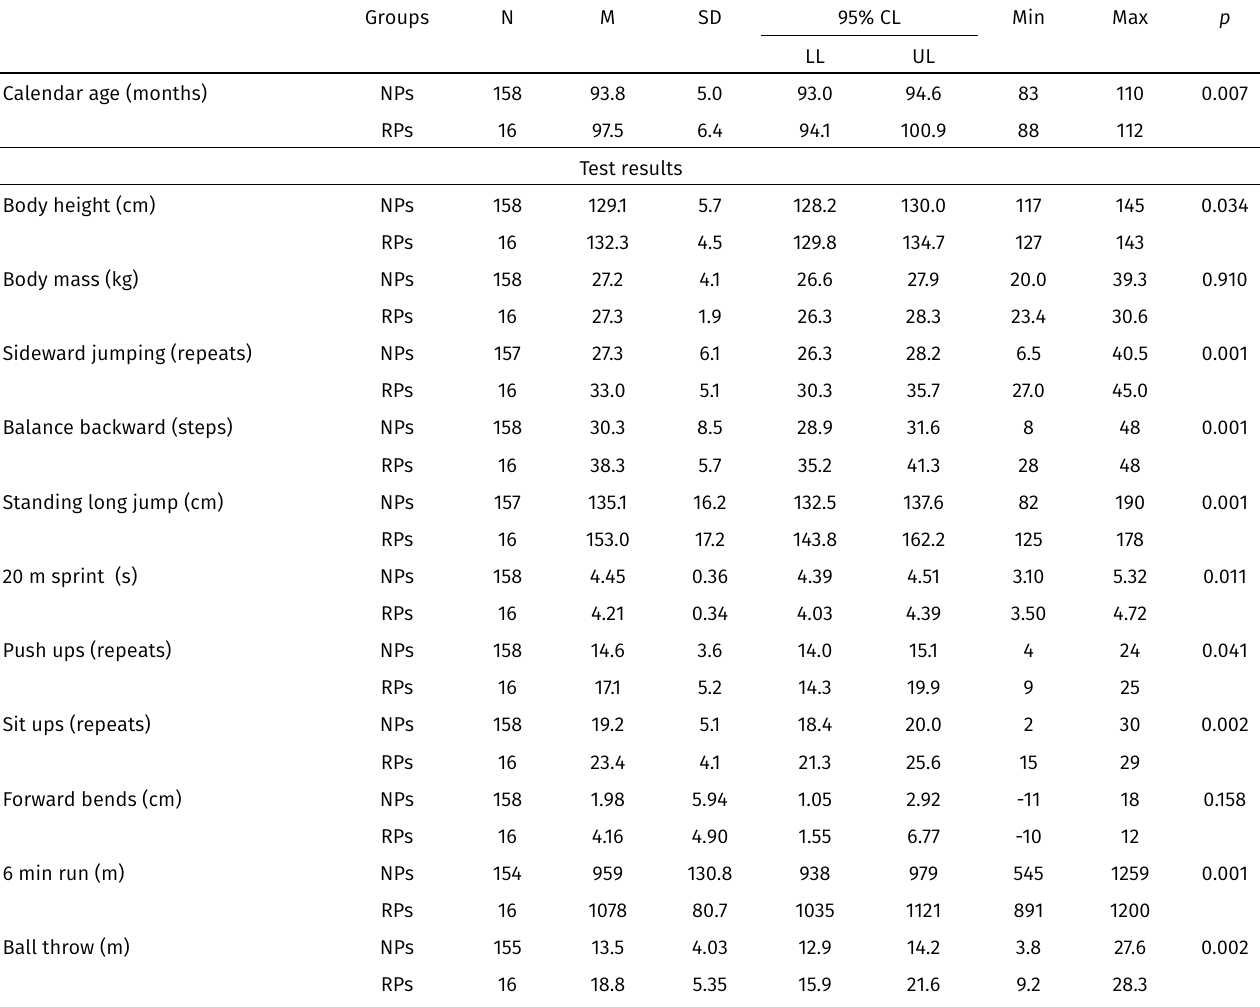
Table 1. ‒ Descriptive statistics for the former U9 test results of the junior tennis players.